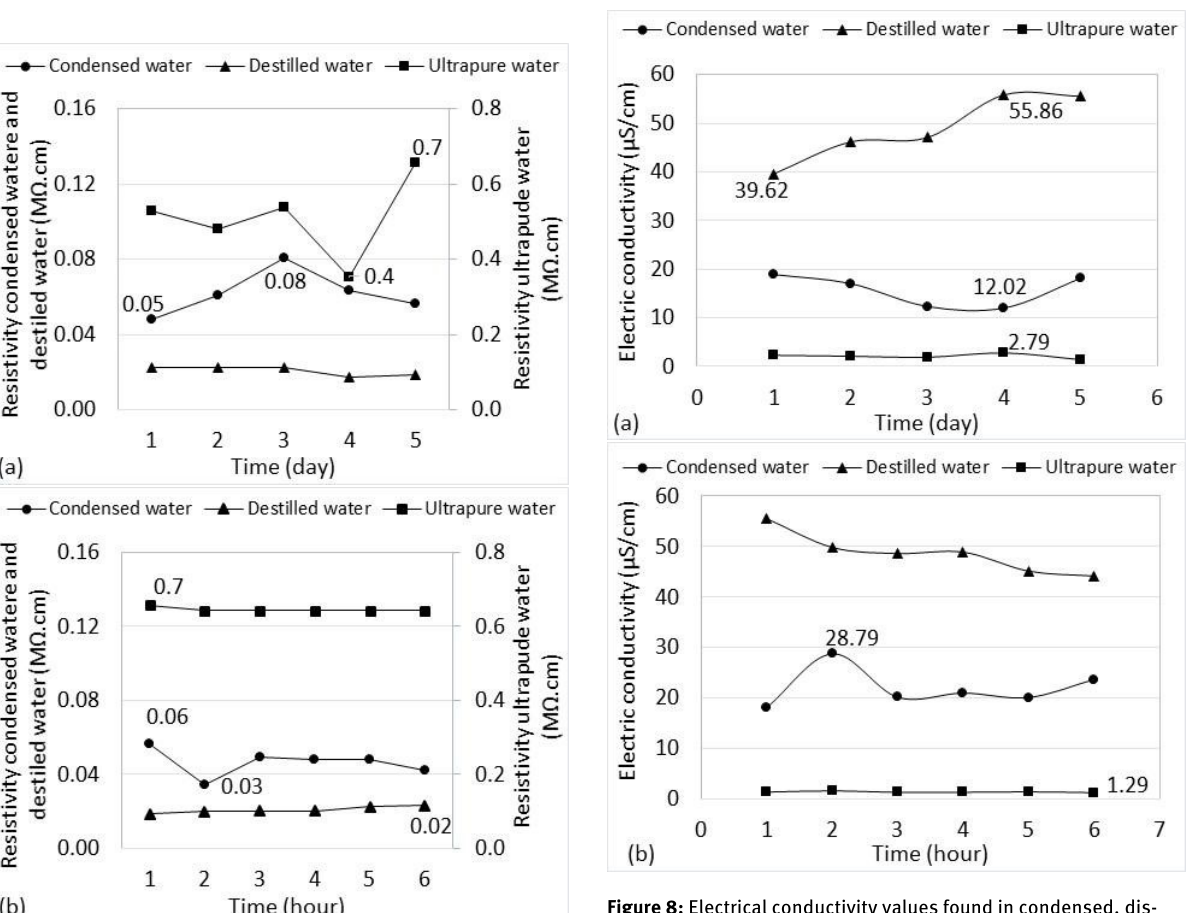
Figure 8: Electrical conductivity values found in condensed, dis- tilled and ultrapure waters, with daily (a) and hourly (b)